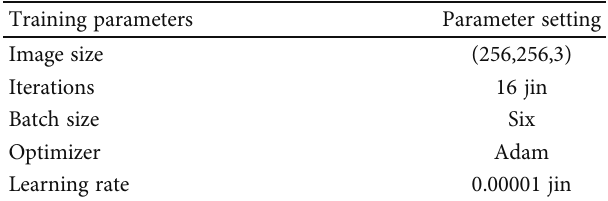
Table 1: Training parameters of neural style transfer model.